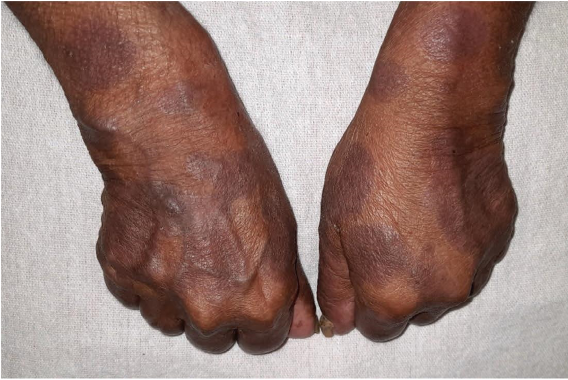
Figure 2: Short fourth and ffth metacarpals.